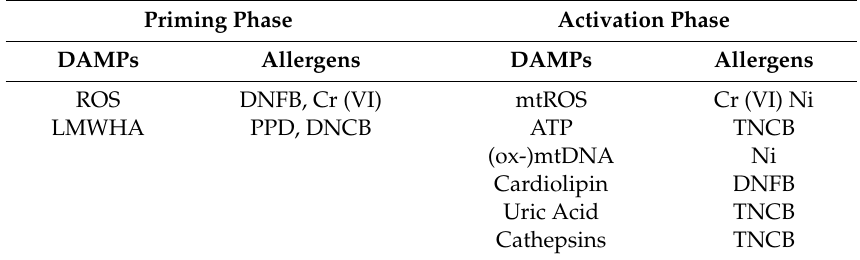
Table 1. DAMPs elicited by allergens and their involvement on NLRP3 inflammasome priming / activation